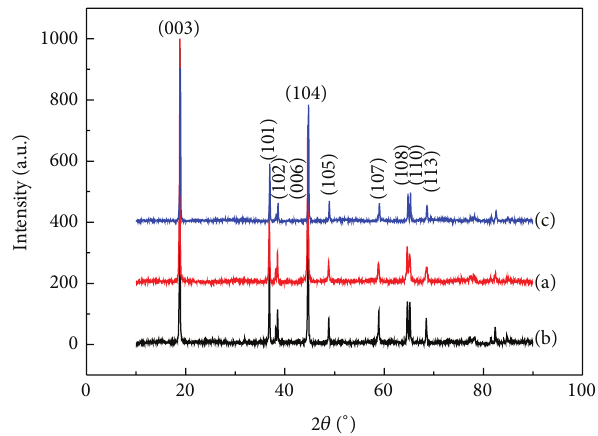
Figure 1: XRD patterns of LiNi 0.7 0.05 ; (c) 𝑥 = 0.1